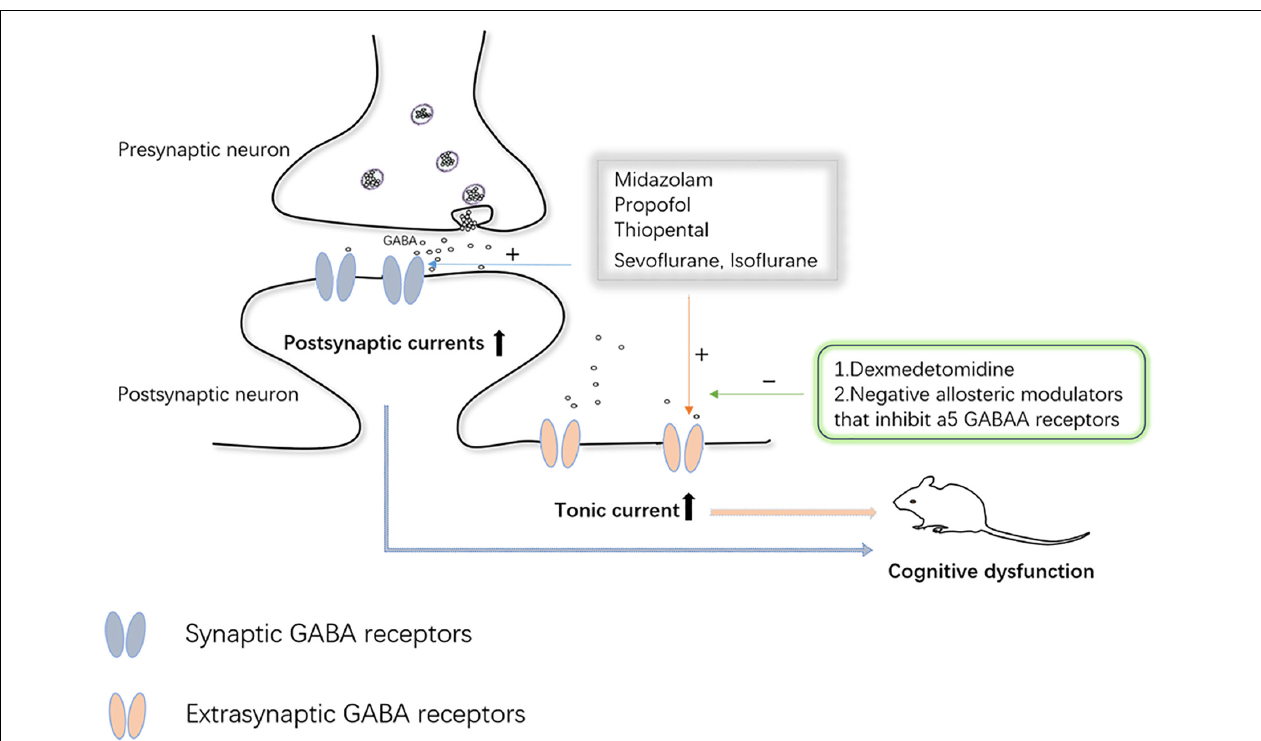
FIGURE 4 | Synaptic and extrasynaptic GABA receptor-mediated inhibition of neuronal